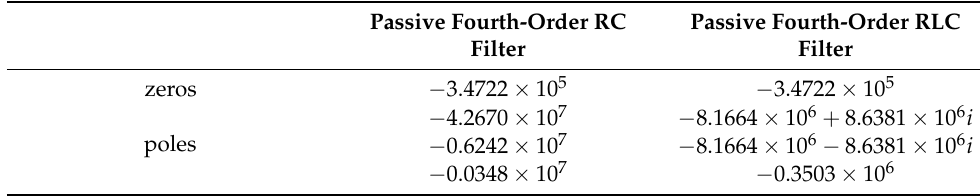
Table 3. Zero-pole location distributions of the two filters.